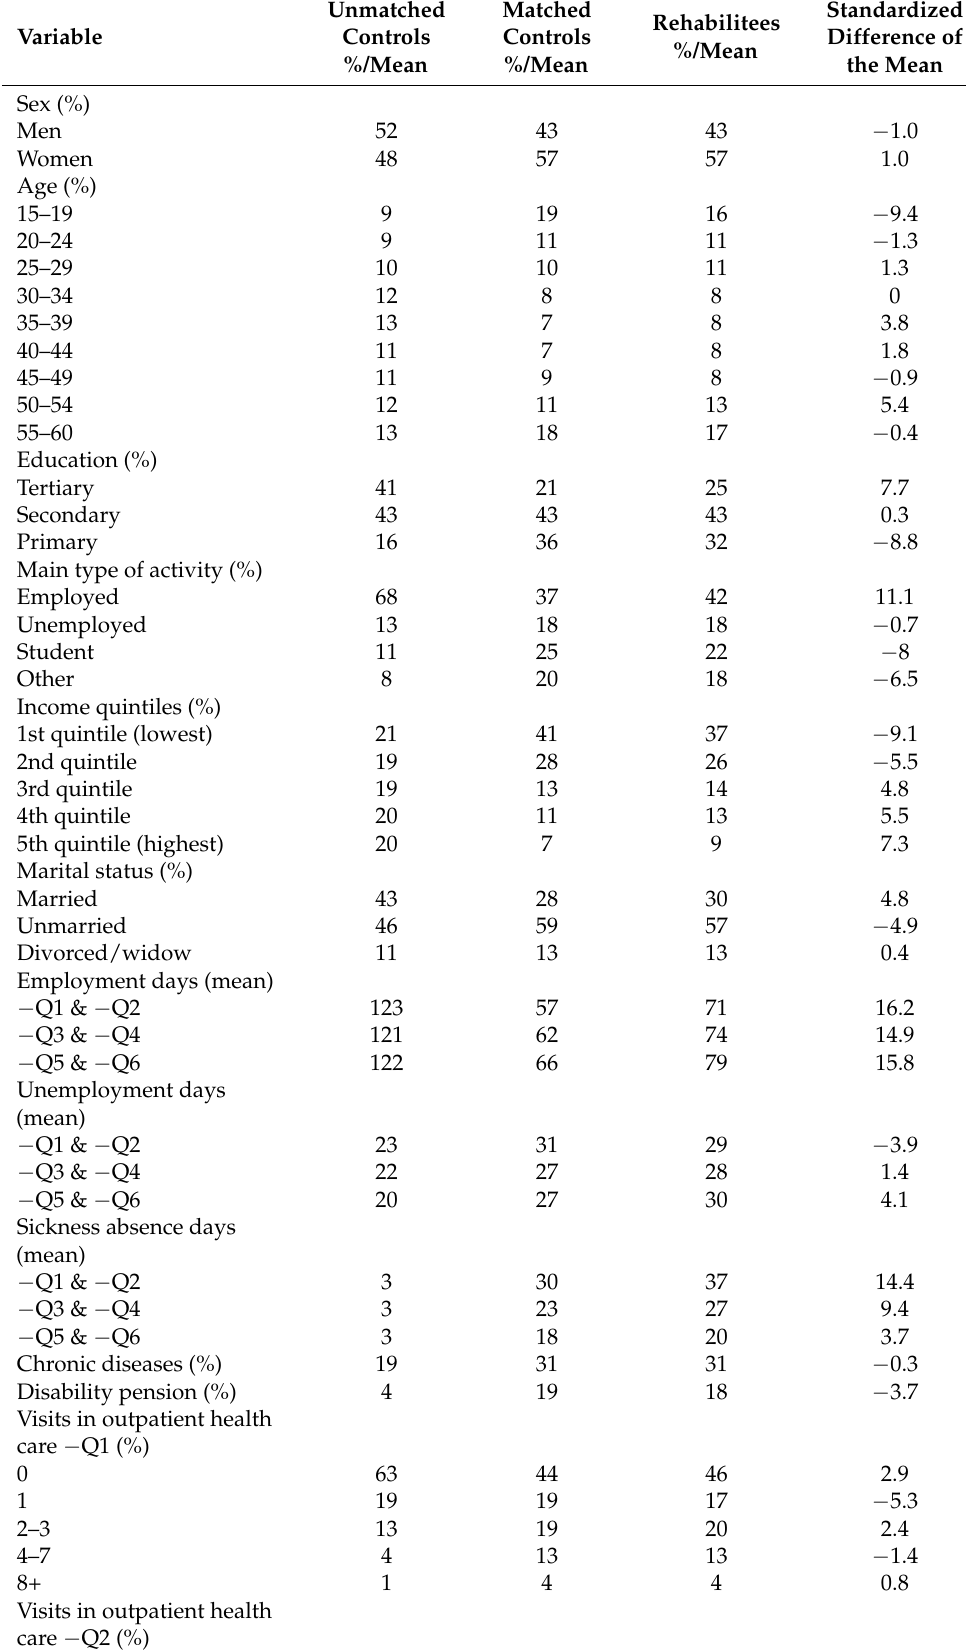
Table 1. Distribution of background factors among rehabilitees, their matched controls and all